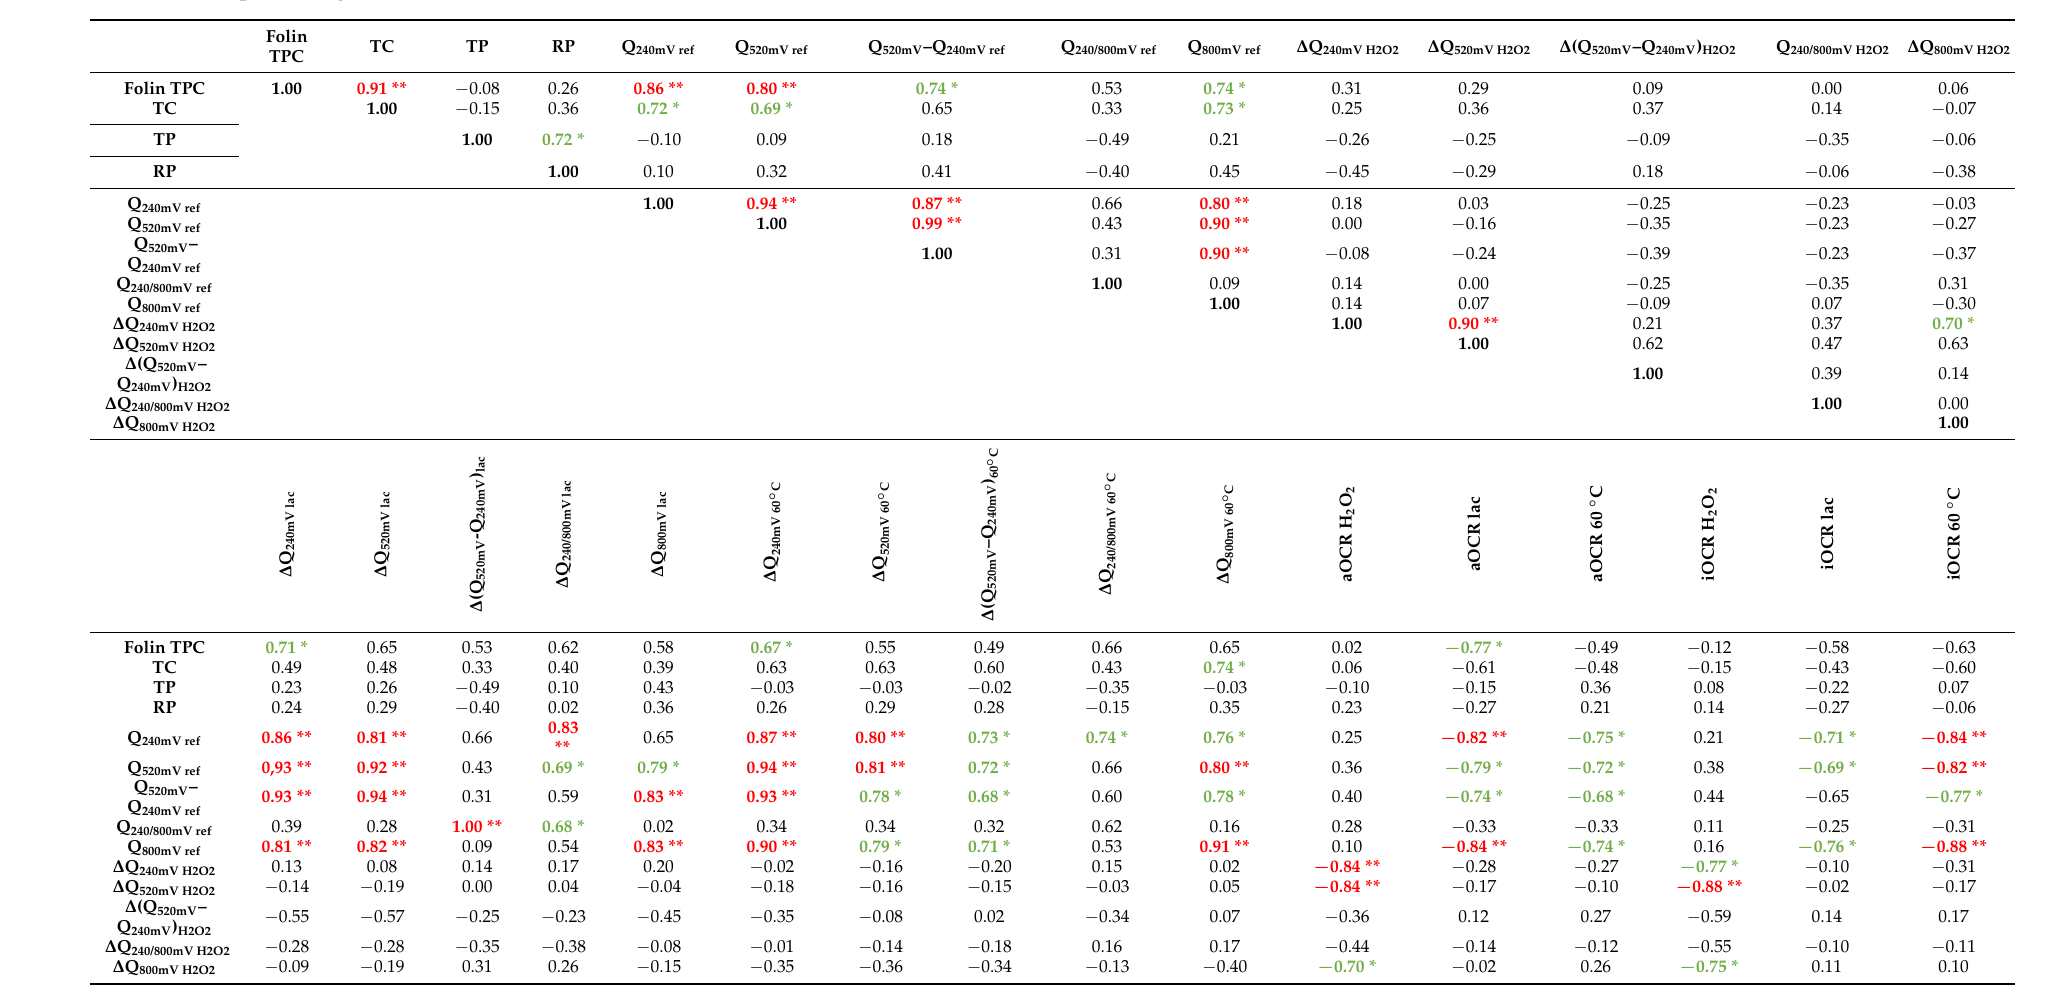
Table 5. Pearson’s correlation coefficients between electrochemical parameters, phenolic composition, and oxygen consumption rates. * (in green) represents significance at p ≤ 0.05 and ** (in red) represent significance at p ≤